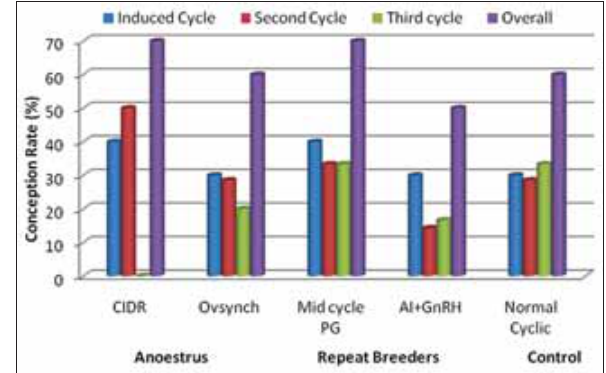
Figure-1: Conception rates at induced or first estrus in anestrus and repeat breeding buffaloes treated with different estrus synchronization protocols and in normal cyclic control